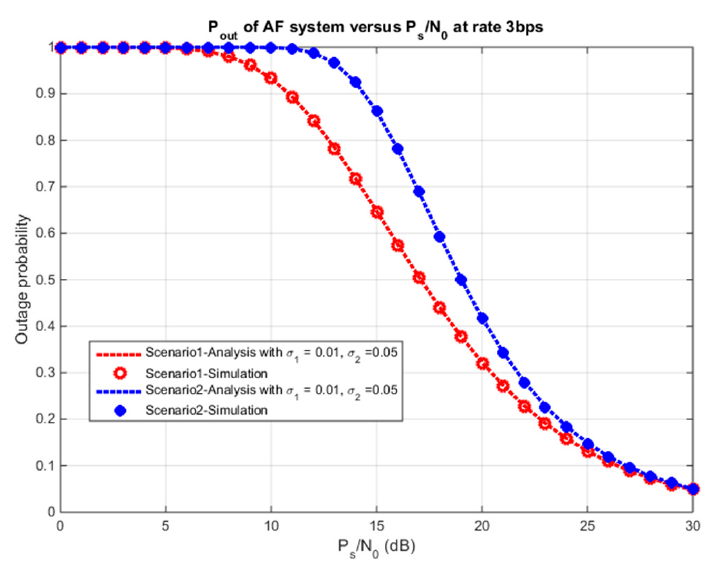
Figure 5. The outage probability versus ratio of P s / N 0 .